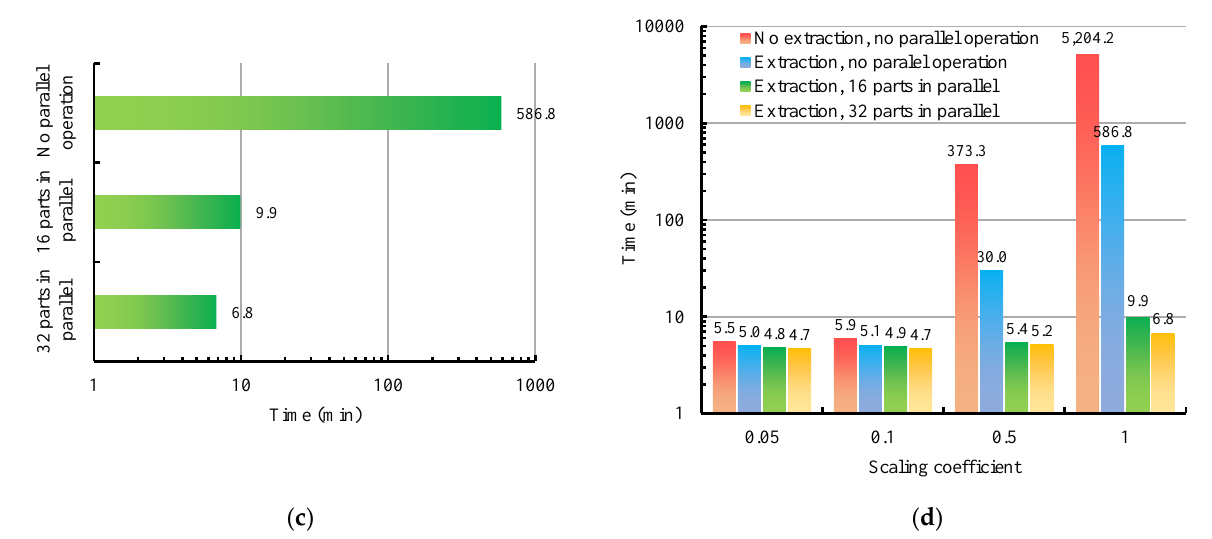
Figure 9. Time needed for image mosaicking in different situations: ( a ) overlapping area extraction or not (no scaling compensation or parallel operation); ( b ) different downsampling degrees of overlapping areas (no parallel operation); ( c ) different parts in parallel (no downsampling); ( d ) mosaic times of the contrast experiments in all situations. Table 4. Time of each processing stage.